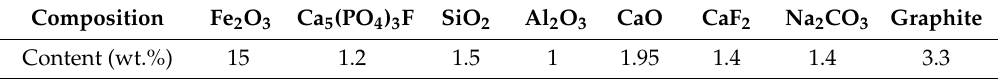
Table 3. The composition of simulated high-phosphorus iron ore.